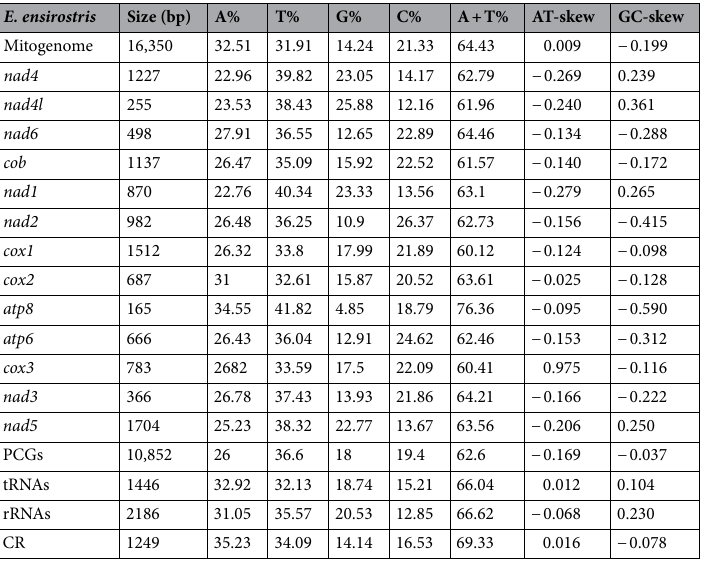
Table 2. Nucleotide composition and skewness of the Exhippolysmata ensirostris mitochondrial genome.